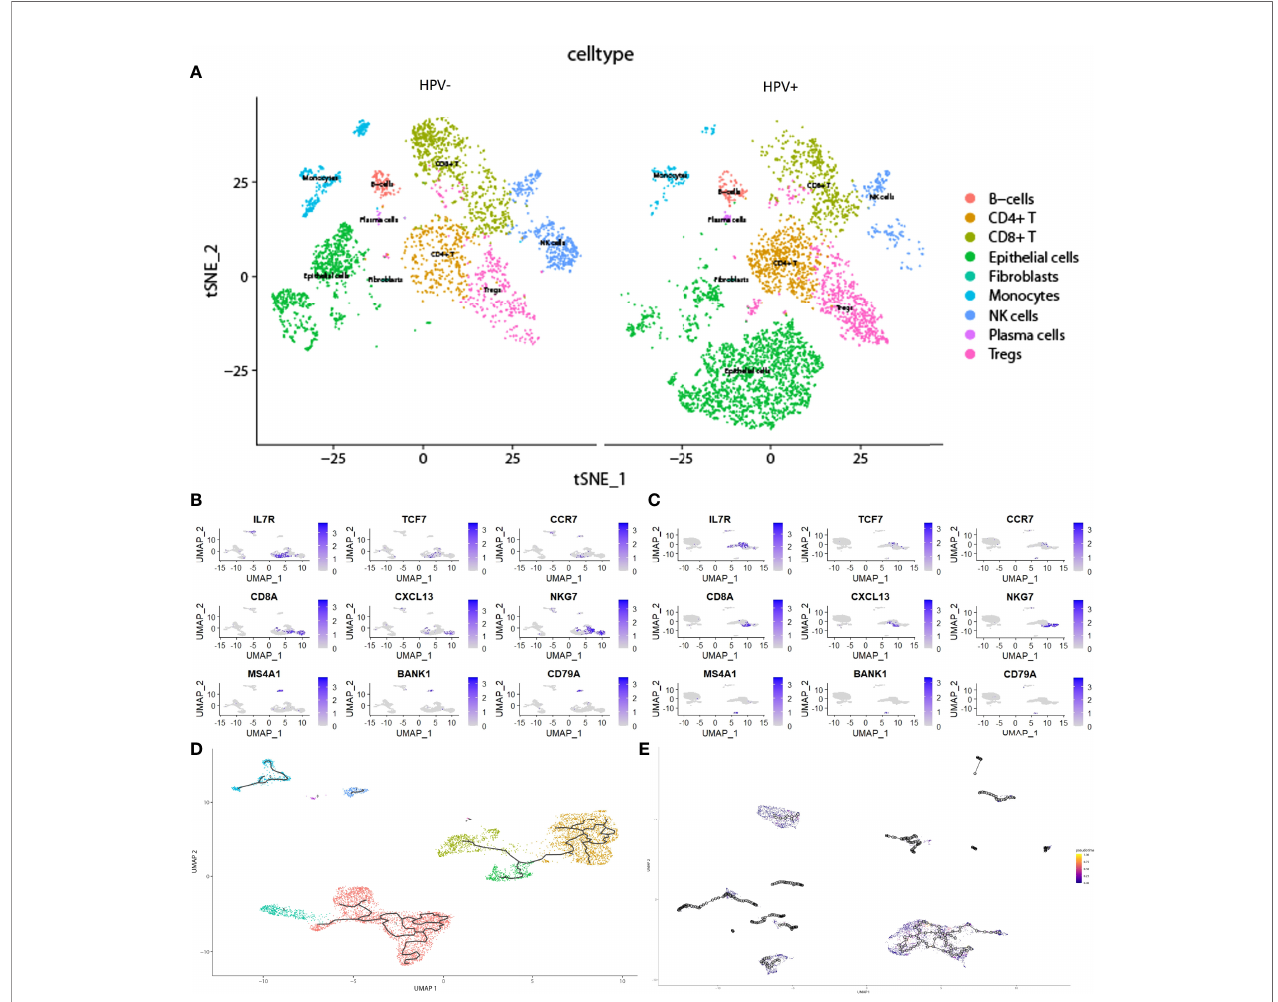
FIGURE 2 | The heterogeneity in HPV+ and HPV- CESC scRNA-seq. (A) Cell type annotation of HPV+ and HPV- group. (B) Top marker genes of CD8+T, CD4+T, and B cells in HPV- group. (C) Top marker genes of CD8+T, CD4+T, and B cells in HPV+ group. (D) Pseudotime and trajectory analysis of HPV- group. (E) Pseudotime and trajectory analysis of HPV+